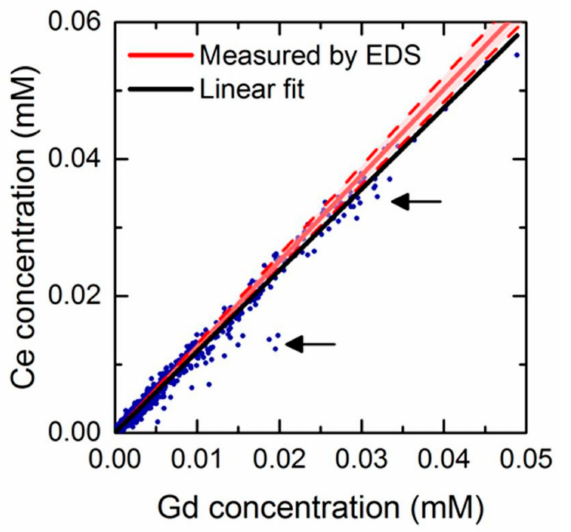
Figure 10. Scatter plot of concentration profile of Ce over Gd in XRF map of cells exposed to nanoparti- cles containing 50% of cerium. The red zones describe the standard deviation of the EDS measurement. The arrows indicate the groups of points that deviate from the linear concentration